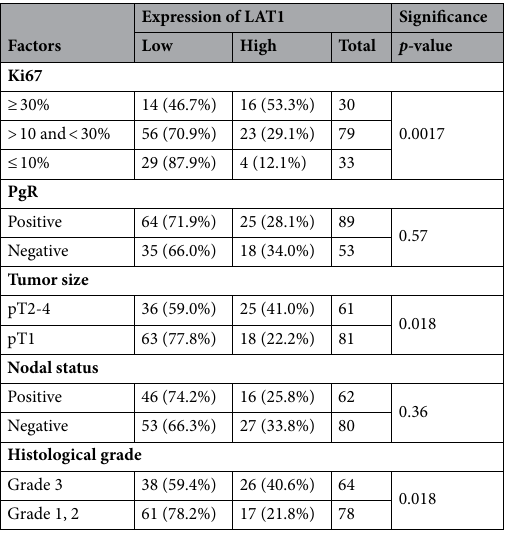
Table 2. Relationship between LAT1 expression and clinicopathological factors in ER-positive/HER2-negative breast cancer. LAT1 L-type amino acid transporter 1, ER estrogen receptor, PgR progesterone receptor, HER2 human epidermal growth factor receptor 2.